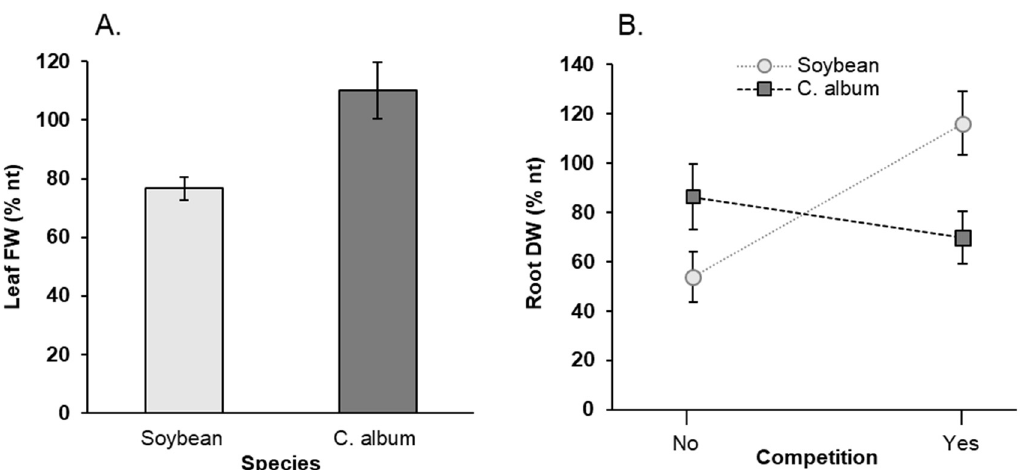
Figure 3. ( A ) Average leaf fresh weight (FW), expressed as percentage of salt-treated samples over nontreated samples (% nt). ( B ) Species-competition interaction for average root dry weight (DW) of soybean and C. album (% nt). Values on the left refer to plants grown in the single-species set-up (no competition). Values on the right refer to plants grown in the mixed-species set-up (competition between soybean and C. album ). Vertical bars denote the standard error. The experiment was replicated twice, and only data from one representative experiment are shown. Table 2. ANOVA significance for the effect of species (soybean and C. album ), competition (single-species tanks or mixed- species tanks) and their interaction on the percentage of salt-treated samples over nontreated samples. ( A ) Fresh weight (FW), dry weight (DW) and DW/FW ratio of leaves and roots. ( B ) Content of N and soluble proteins in leaves. ( C ) Na+ and K+ content in leaves and roots, Na and K translocation factor (Na leaves/Na roots, K leaves/K roots). ( D ) Phenolic compounds in leaves and roots and antioxidant capacity via FRAP in leaves and roots. ( E ) Antioxidant enzyme activity (guaiacol peroxidase (GPX), ascorbate peroxidase (APX), catalase (CAT) and lipid peroxidation via malondialdehyde (MDA) assay in leaves. ( F ) Proline content in leaves and roots. ns = not significant A